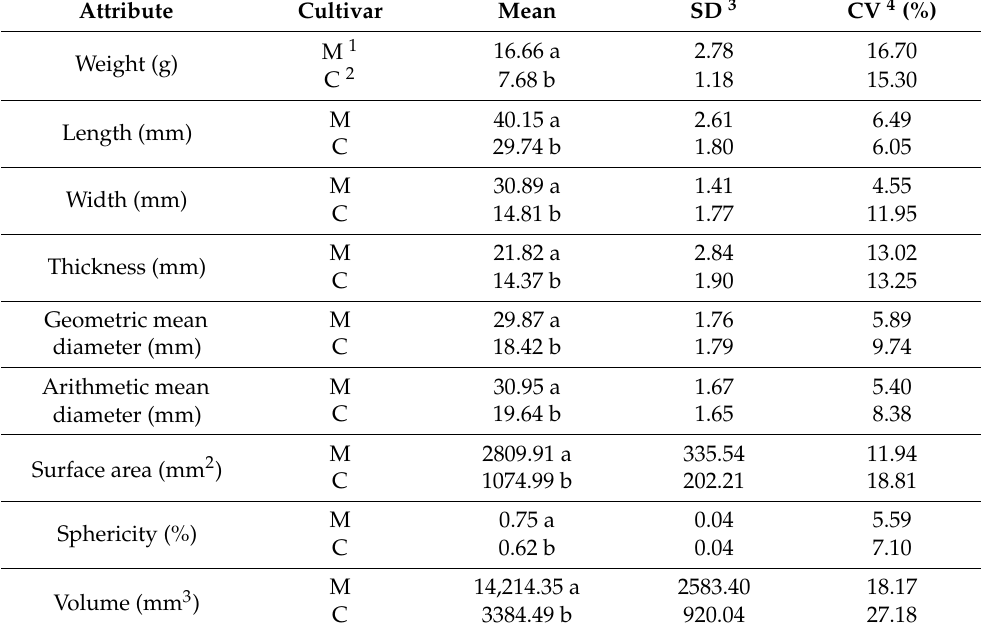
Table 2. Fruit weight and morphological attributes of the two chestnut